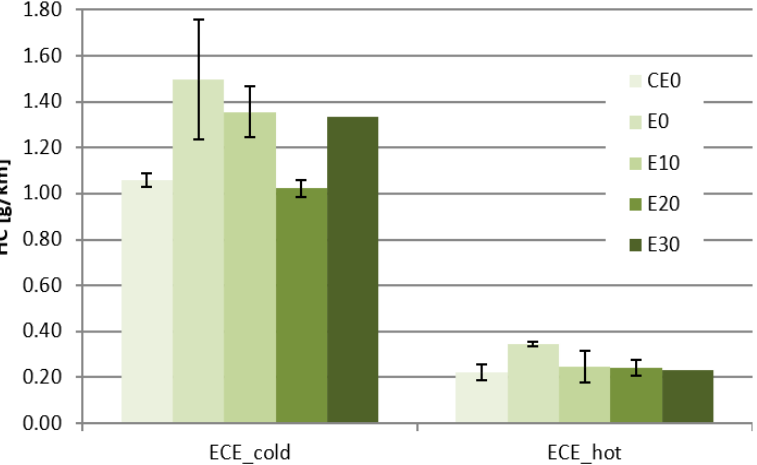
Figure 2. HC emission factors measured on the hot and cold phases of the ECE driving cycle: comparison between commercial gasoline (CE0), oxygen-free gasoline (E0), 10% ethanol v / v (E10), 20% ethanol v / v (E20) and 30% ethanol v / v (E30) [27]. Reproduced with permission from